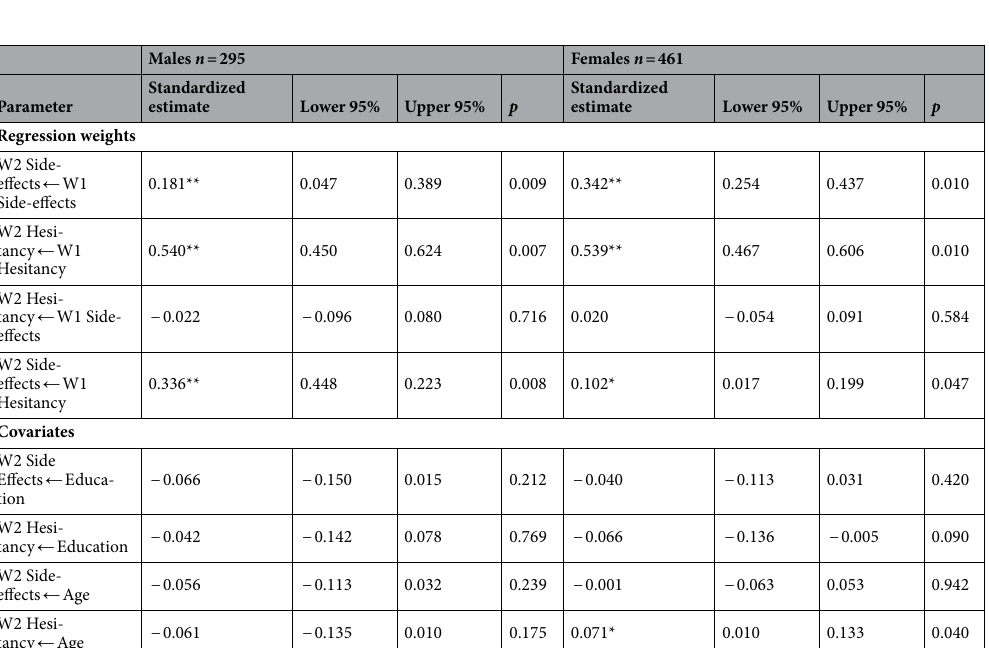
Table 3. Parameters for the cross-lagged models n = 756. *** p < 0.001 ** p < 0.01 * p < 0.05.